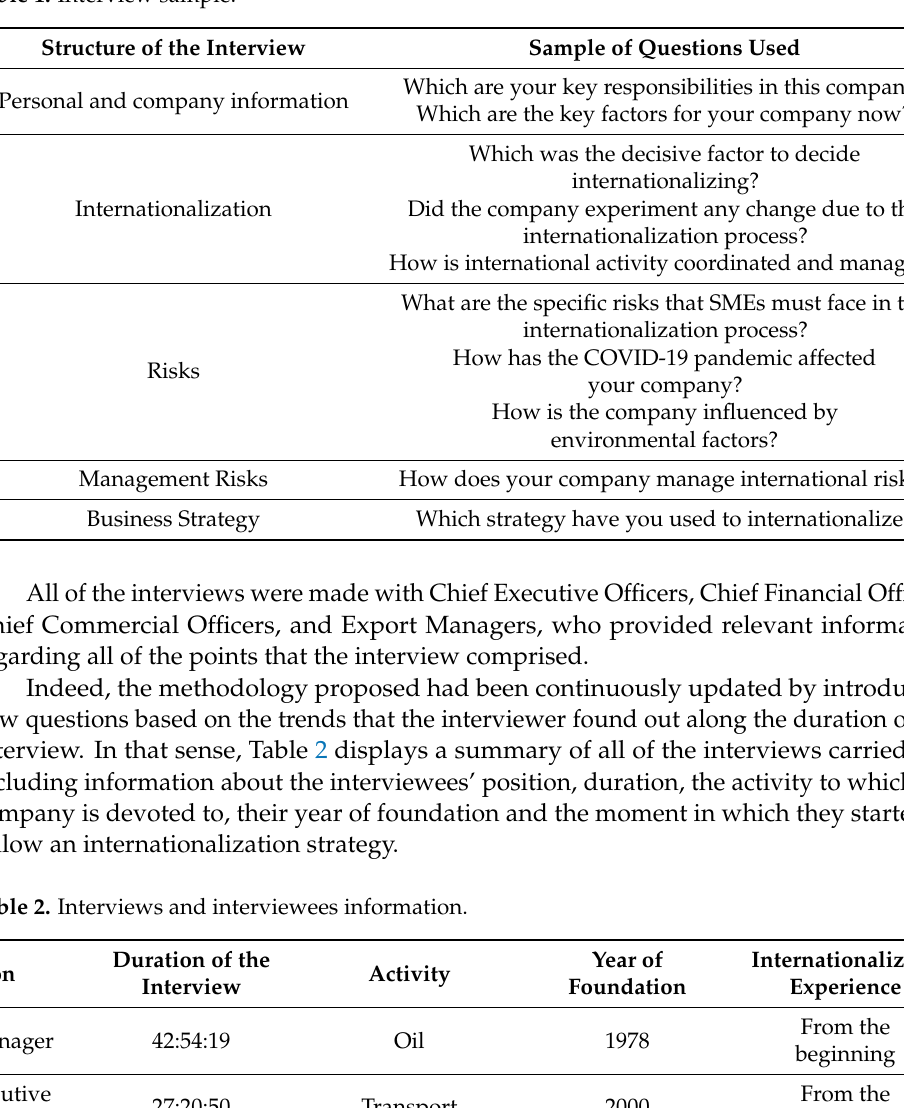
Table 1. Interview sample.